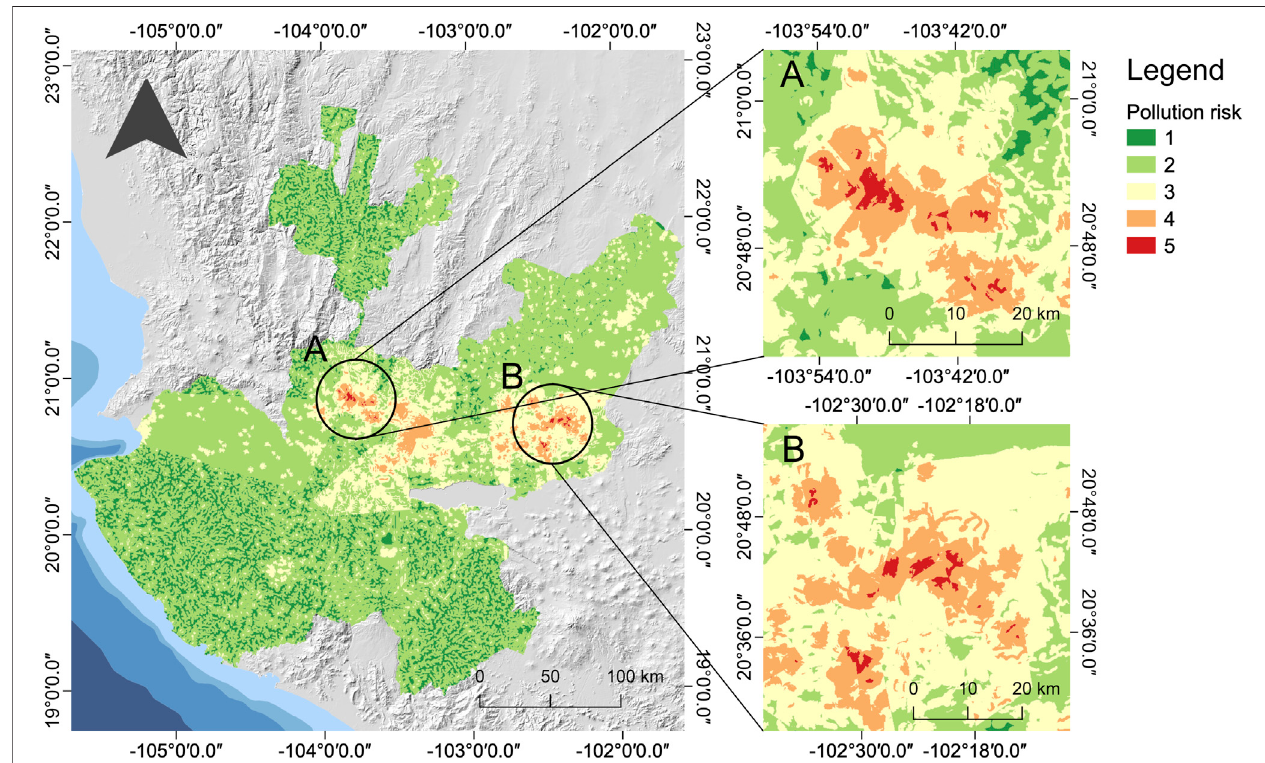
FIGURE 4 | Critical zones determined within the middle-western (A) and eastern (B) areas of the state of Jalisco.